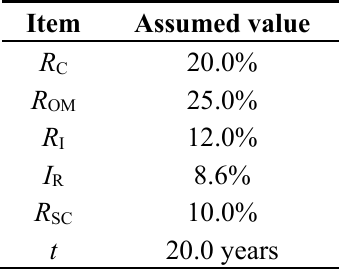
Table 5. Assumptions used for the econometrics analysis